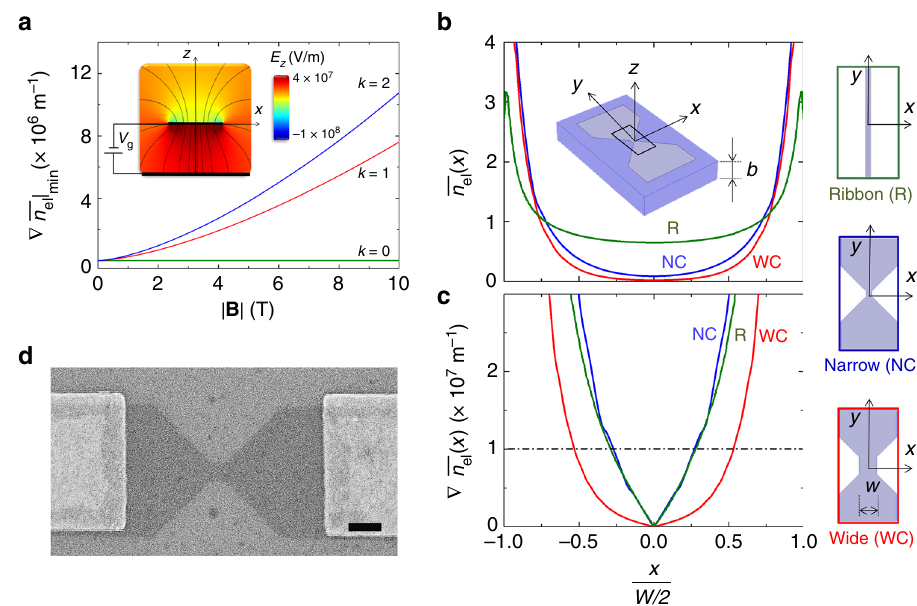
(Eq. (1)) required for a min